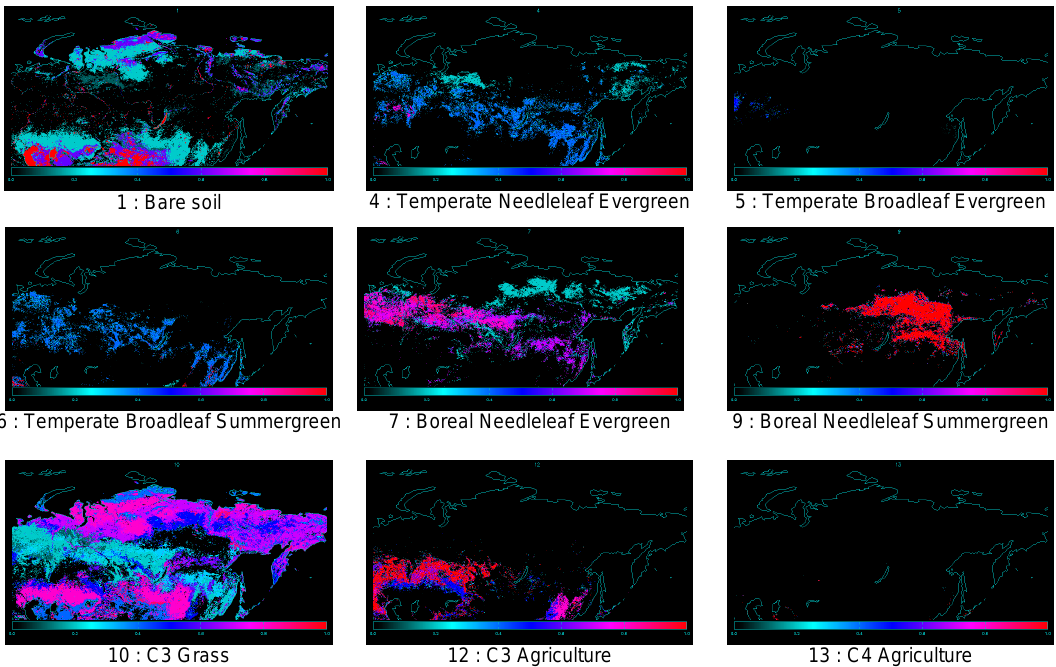
Figure 5. Standard ORCHIDEE PFT maps. The respective fractions of the following nine classes are represented in color scale, from blue (0%) to red (100%): bare soil (PFT1), temperate needleleaf evergreen (PFT4), temperate broadleaf evergreen (PFT5), temperate broadleaf summergreen (PFT6), boreal needleleaf summergreen (PFT9), C3 grass (PFT10), C3 agriculture (PFT12), and C4 agriculture (PFT13).